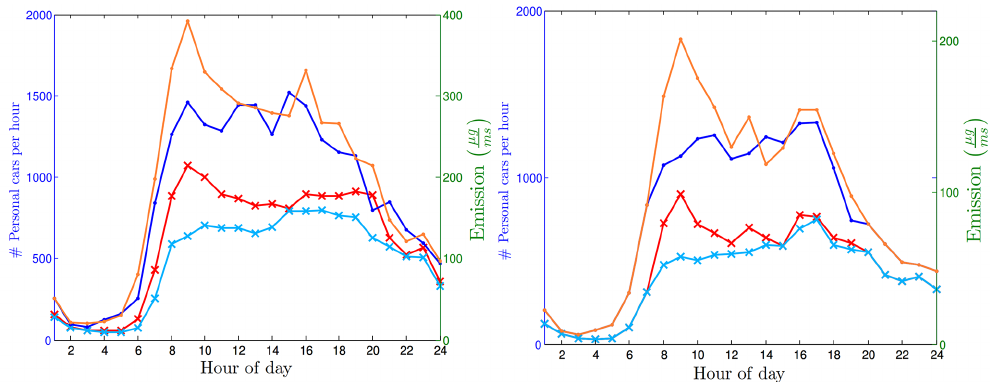
Figure 10. Diurnal variation for weekdays in personal cars per hour and total NO x emissions for all vehicles for 2003 (left) and 2013 (right). The red and orange graphs are for the northeast direction and the blue graphs are for the southeast direction. The curves marked with dots are the emissions and the curves marked with crosses are the number of personal cars per